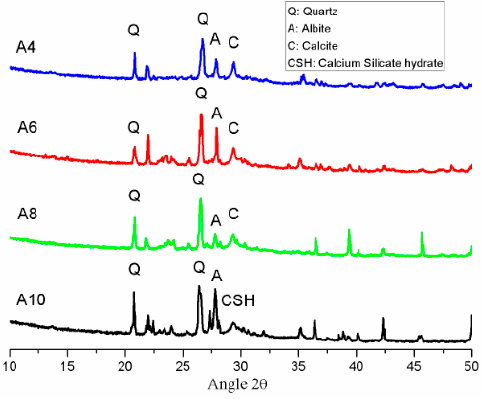
Figure 10. XRD patterns of AAS mortar with different concentration of Na 2 O before exposure.